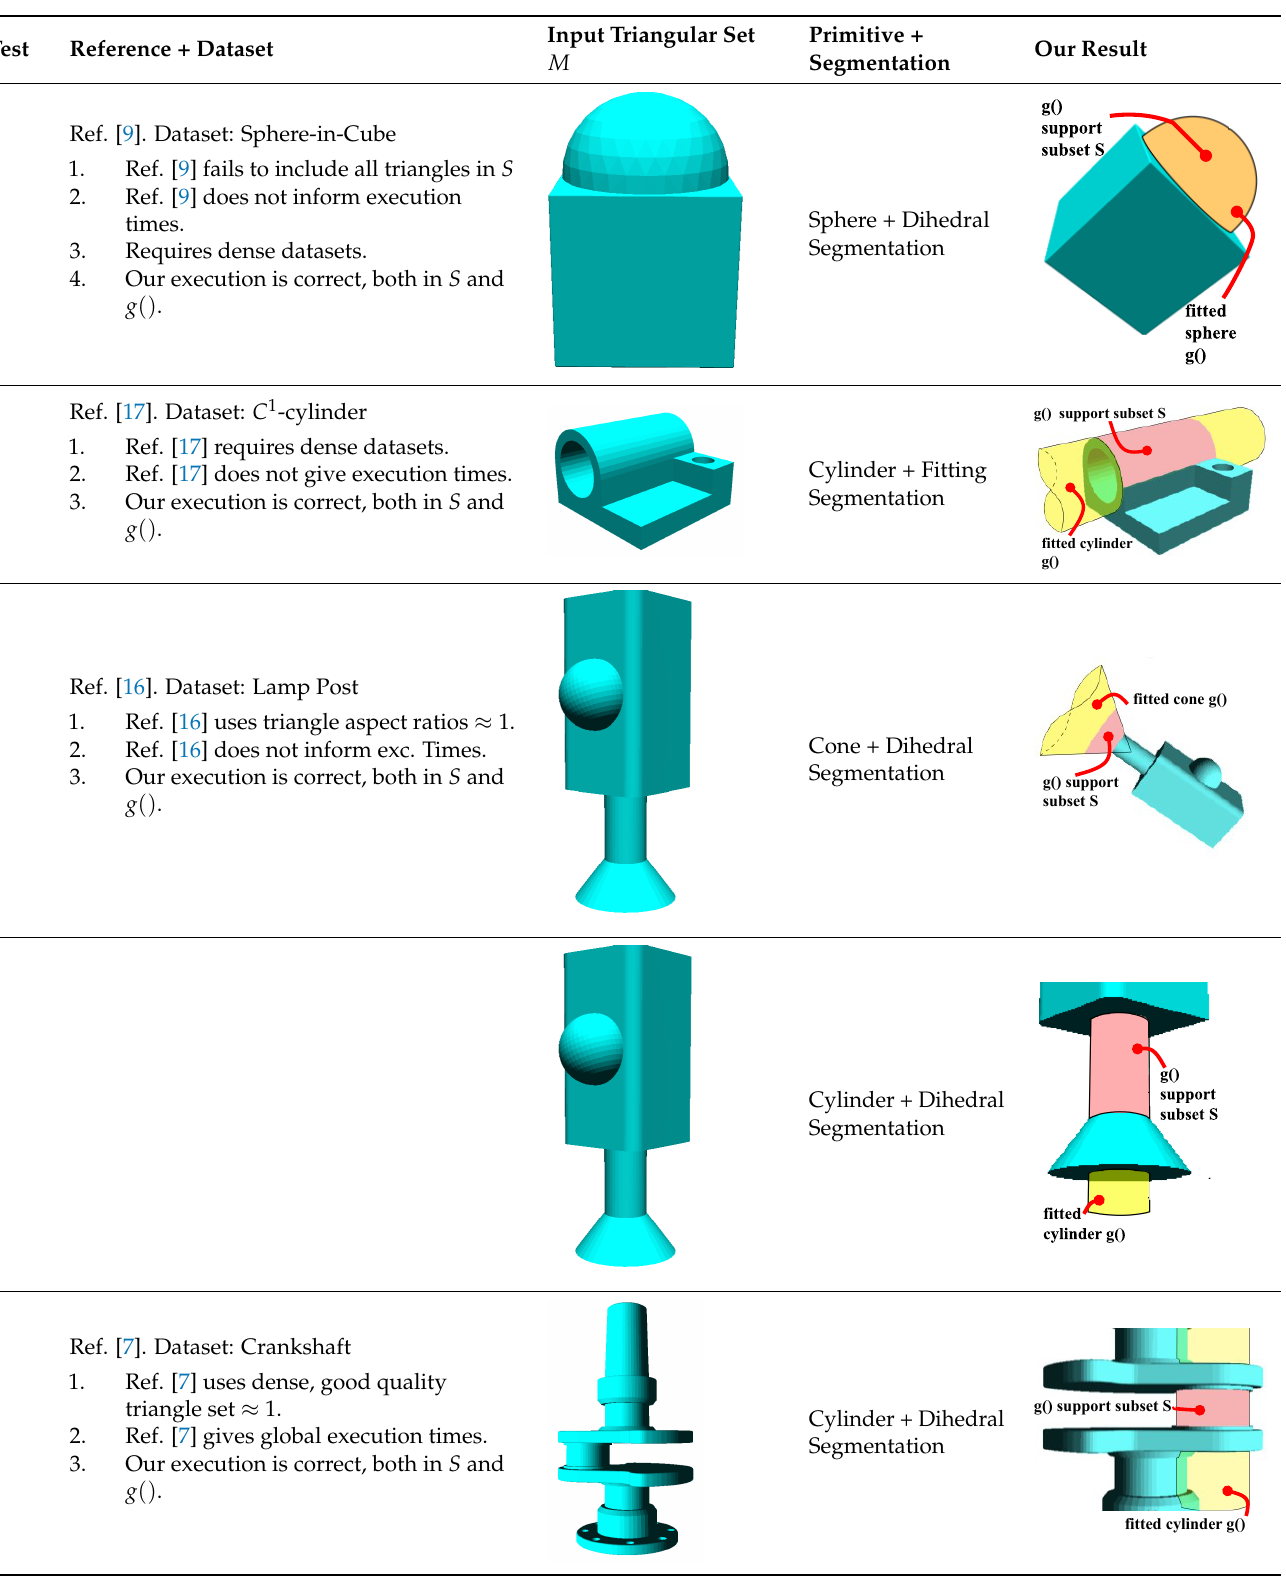
Table 9. Test with reference datasets of competitor